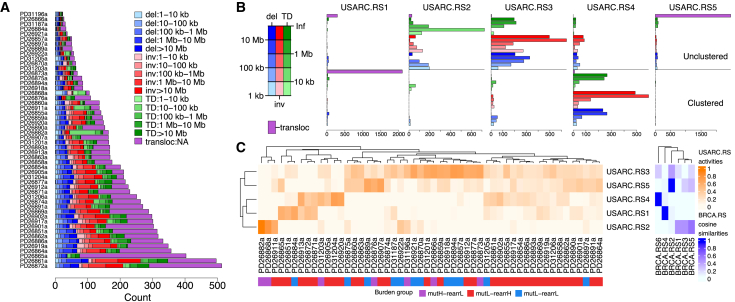
Rearrangement Signatures(A) Rearrangement diversity and counts in the USARC cohort, classified by rearrangement size and rearrangement class.(B) Five rearrangement signatures identified by non-negative matrix factorization (NMF); USARC.RS1, clustered translocations (tloc, purple); USARC.RS2, small unclustered tandem duplications (TD, green), inversions (inv, red), and deletions (del, blue); USARC.RS3, large unclustered TDs, invs, and dels; USARC.RS4, large clustered TDs, invs, and dels; USARC.RS5, unclustered tlocs. x axis, strength of each rearrangement class in each signature.(C) Contribution of activities of each signature per sample (left) and cosine similarities between published breast cancer rearrangement signatures (BRCA.RS1-6) and USARC rearrangement signatures (right). See also Figure S4 and Table S4.